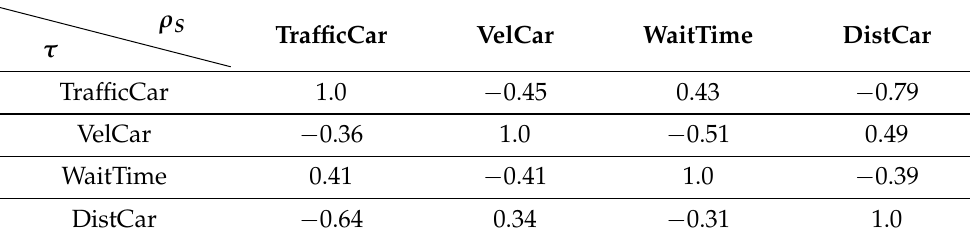
Table 3. Rank correlation coefficients, Kendall’s τ and Spearman’s ρ .